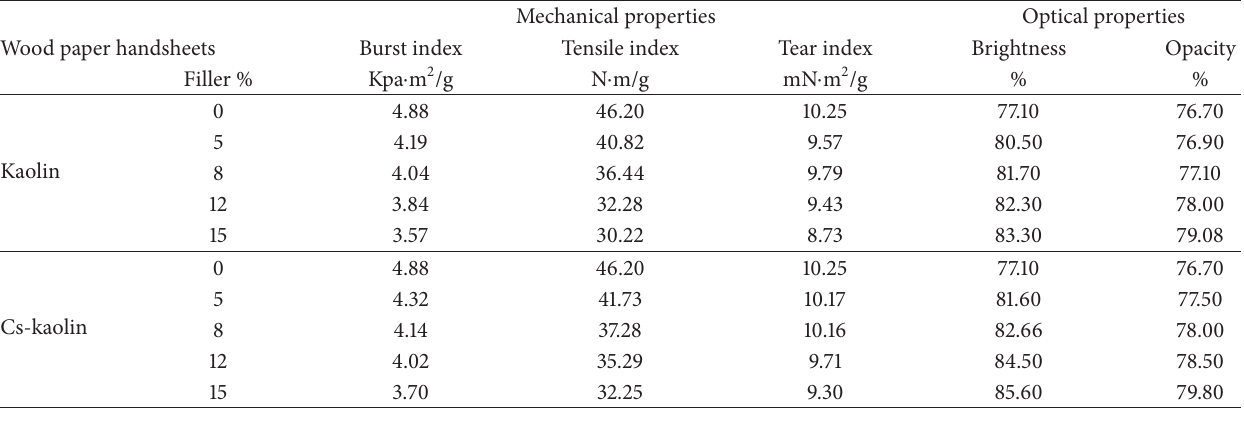
Table 1: Mechanical and optical properties of wood paper handsheets loaded with native kaolin and Cs-kaolin. Mechanical properties